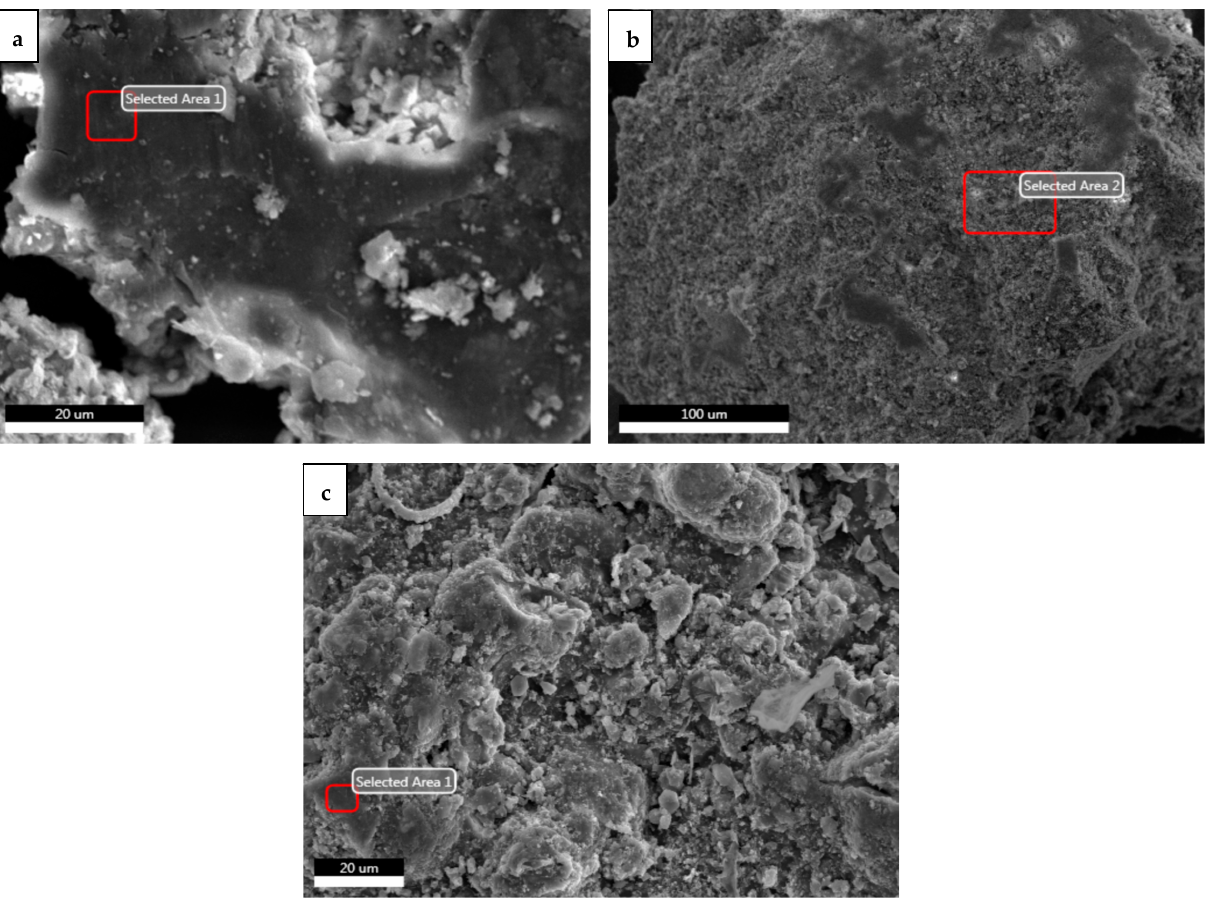
Figure 5. The optical microscopic picture of dyed fibers.